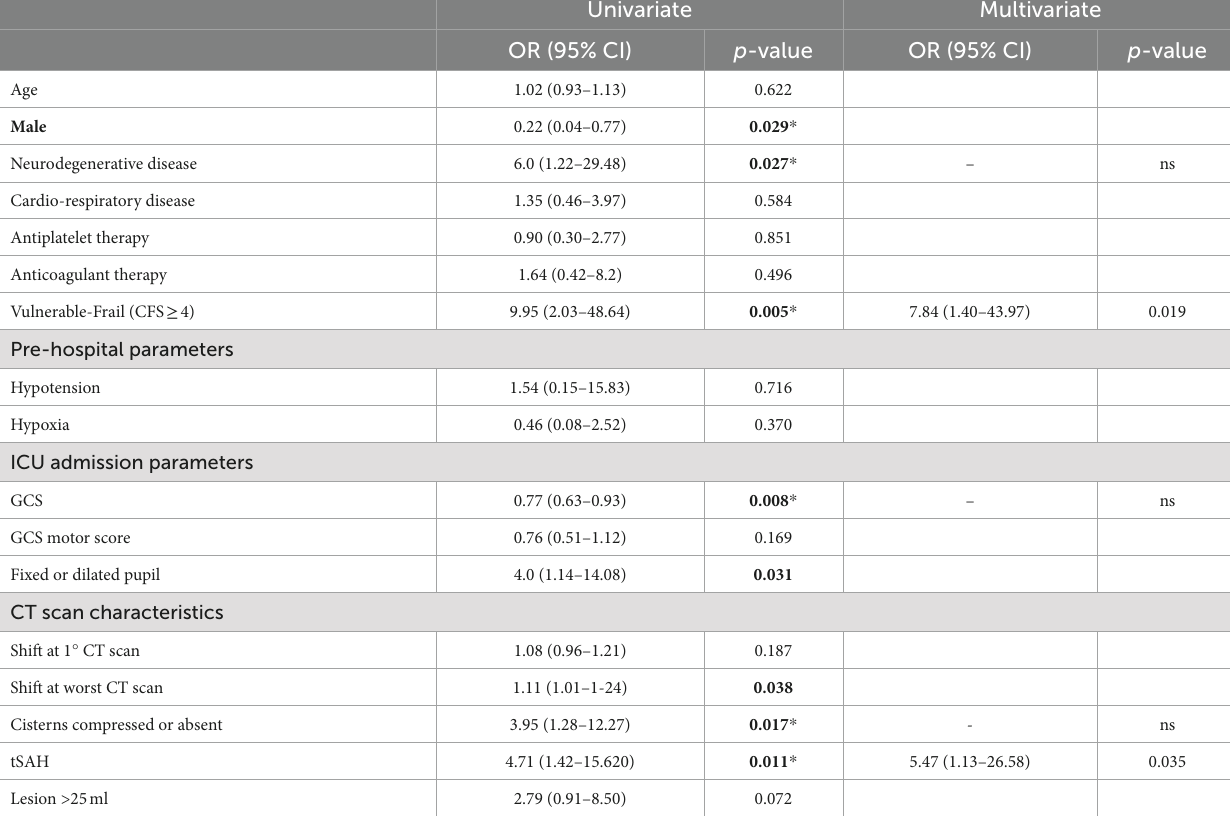
TABLE 2 Univariate and multivariate analysis for GOSE at